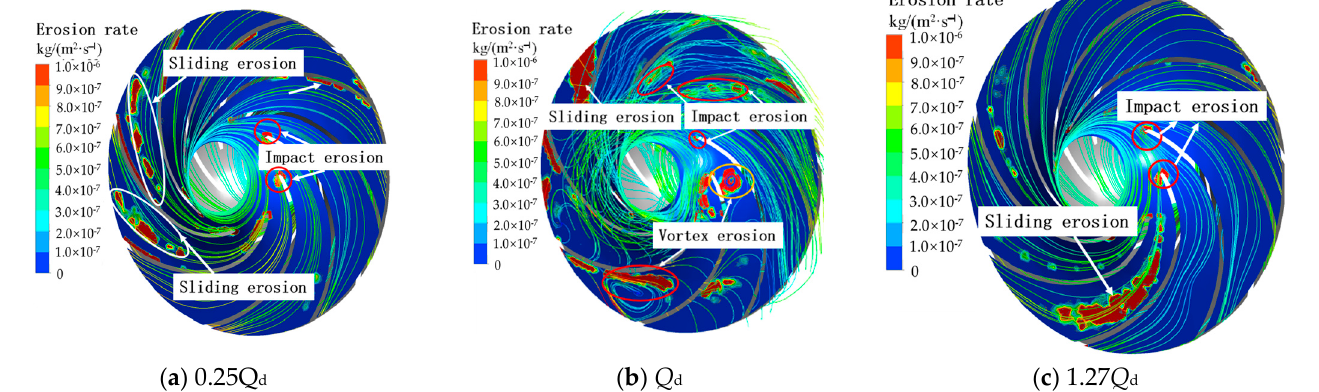
Figure 10. Erosion distribution of hub under different flow rate conditions (15 kg/m 3 ).